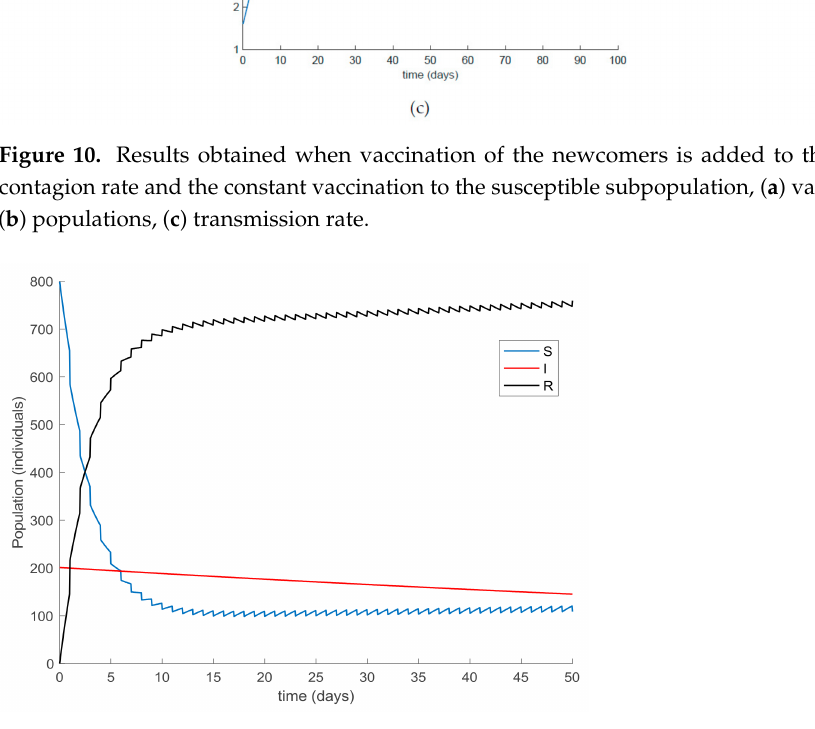
Figure 11. Evolution of all subpopulations when an impulsive vaccination of the susceptible individ- uals is added to the previous